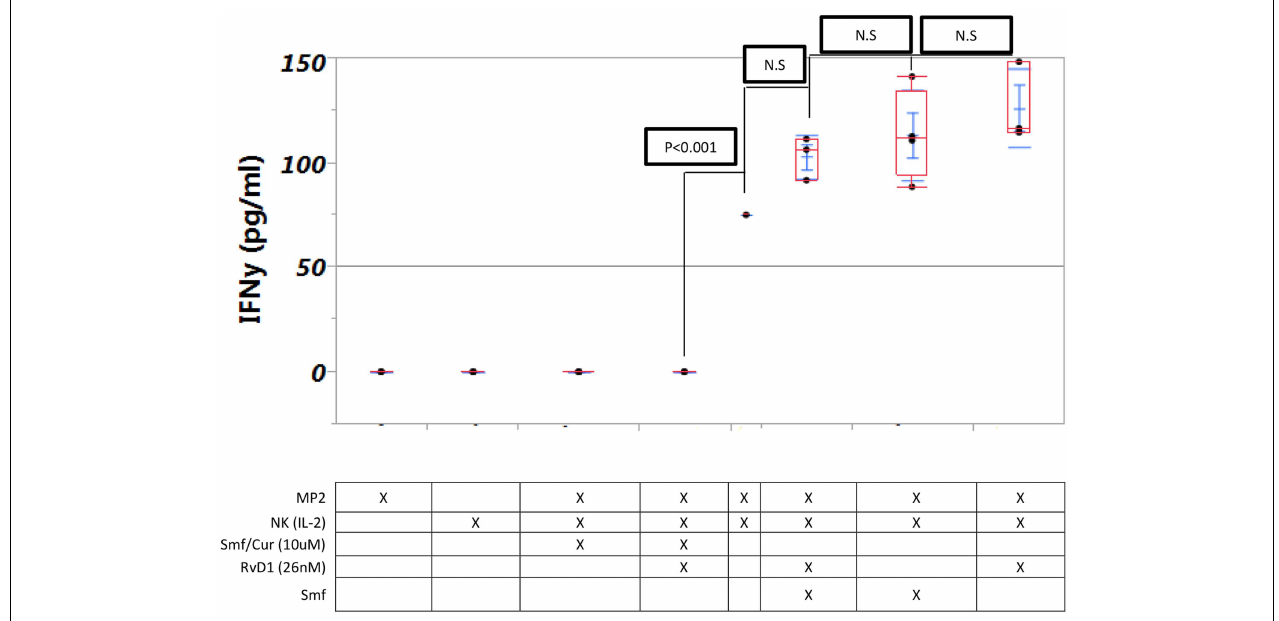
FIGURE 5 | Interferon- γ production by NK cells is not changed by ω -3 or RvD1 but is blocked by curcuminoids. Triplicate MP2 cell cultures in 24-well plates were cultured with NK cells with or without Smartfish emulsion, curcumin, or RvD. Note blockade of IFN- γ by curcumin.